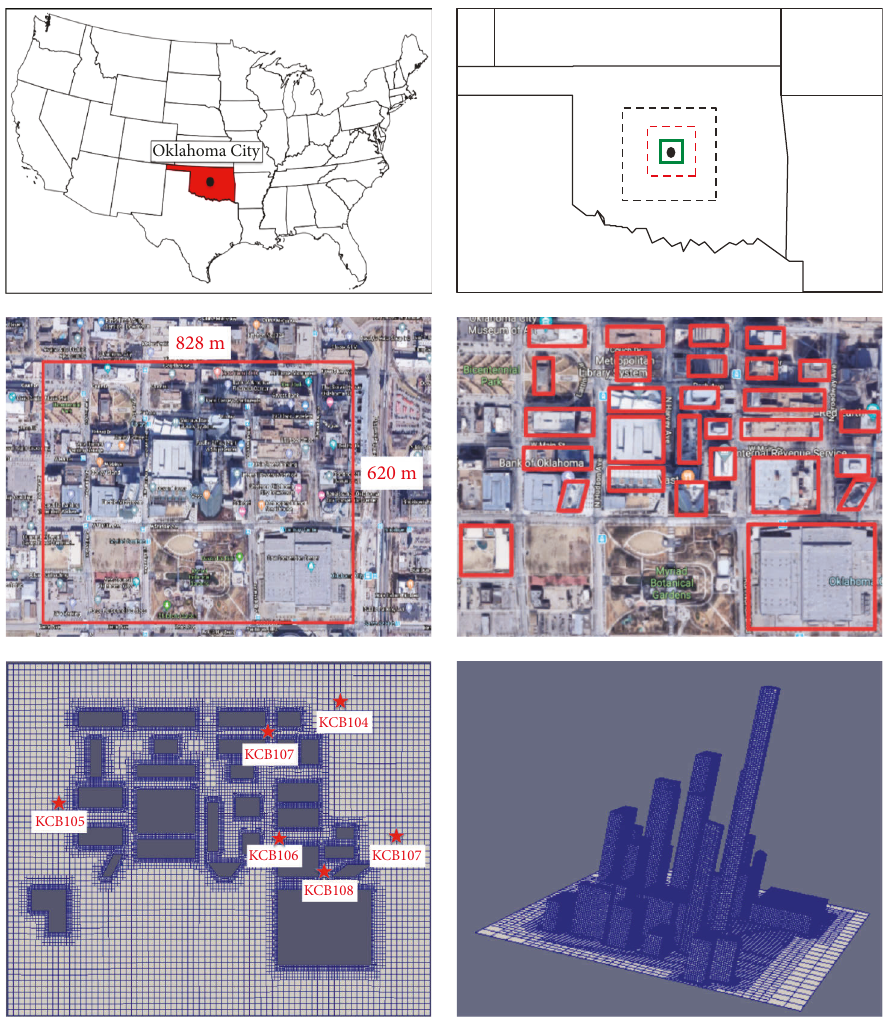
Figure 1: Top left panel: Location of Oklahoma City (blue point) and the state of Oklahoma in red. The black point shows the location of Oklahoma City. Top right panel: three modeling domains: D1 with black dashed rectangle, D2 with red dot-dashed line rectangle, and the LES domain (D3) with green solid lines. The black point shows the location of Oklahoma City. Middle left panel: 2D Google Earth image of Downtown OKC and the red rectangle indicating the CFD domains horizontal boundaries with their corresponding dimensions. Middle right panel: 2D Google Earth image of the CFD domain and the modeled buildings delimited by red rectangles. Bottom left panel: wireframe of the CFD domain ground boundary. The red stars represent the locations of the six Micronet stations. The name of every location is shown in the white box below each red star. Bottom right panel: 3D model of the Oklahoma City block. Table 1: List of the six Micronet stations in Downtown OKC and their corresponding latitude, longitude, and above sea level